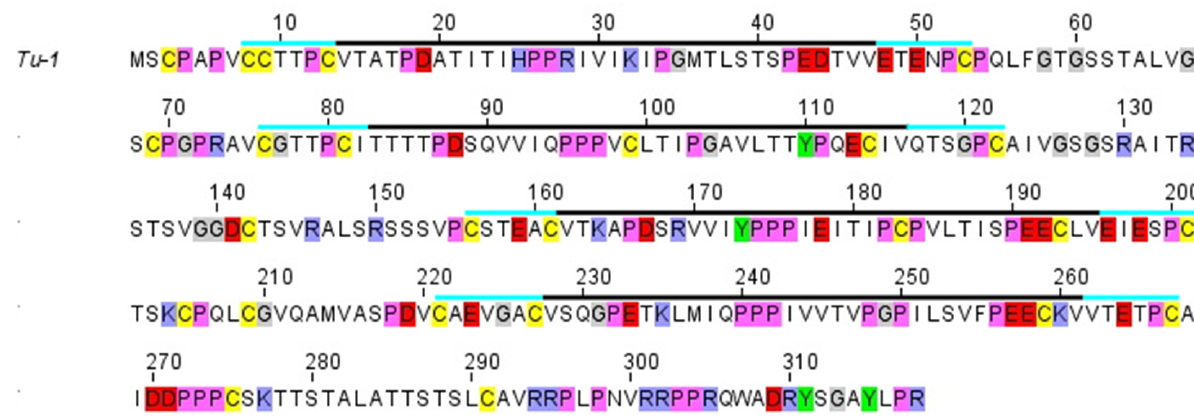
Figure 6. Amino acid sequence of the tuatara chain with four 34-residue repeats. Each repeat is marked with a solid black line. Bars at either end (turquoise) indicate short conserved regions believed to have a role in stabilization or assembly. Color coding for selected amino acids is as follows: cysteine (yellow), proline (magenta), glycine (grey), tyrosine (green), acidic residues (red), and basic residues (blue). Figure reproduced from [5] with permission of